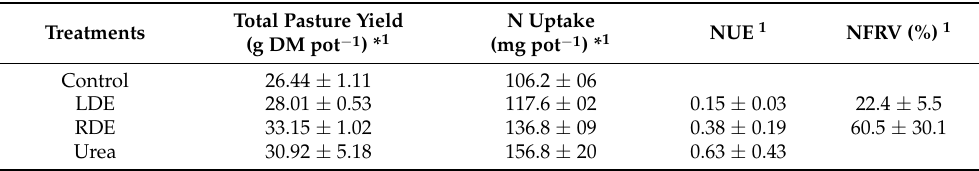
Table 2. Total yield of F. arundinacea , N uptake, N-use efficiency (NUE), and N fertilizer replacement values (NFRV%) from raw (RDE) and lagoon dairy effluents (LDE) or urea fertilizer amendment soil (mean n = 3 ±